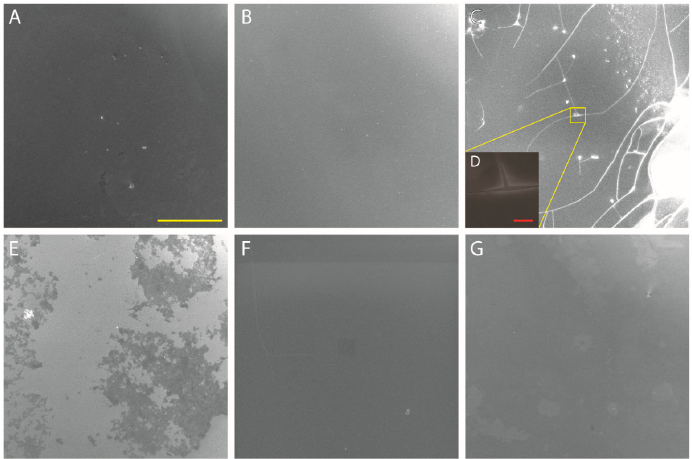
Figure 9. Field Emission Scanning Electron Microscopy (FESEM) images of MUL samples. ( A ): Pristine surface; ( B ): pH 2; ( C ): pH 4; ( D ): magnification of pH 4 region of interest; ( E ): pH 7; ( F ): pH 10; ( G ): pH 12. Yellow bar = 200 µm; Red bar (only D) = 5 µm.